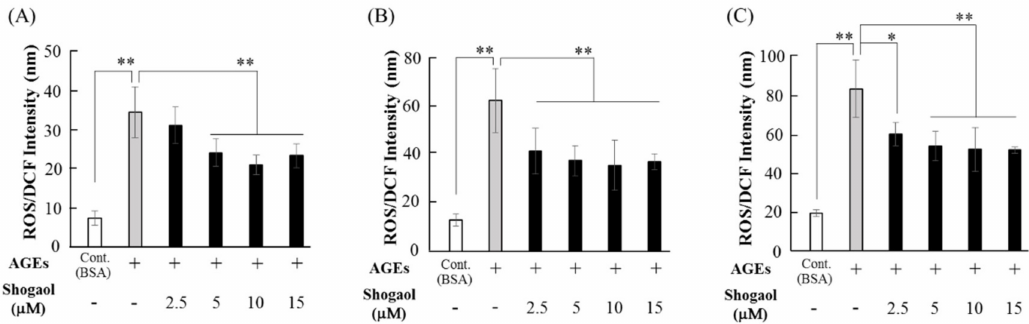
Figure 2. E ff ects of 6-shogaol on AGEs-induced ROS activity. Sub-confluent HGFs were pretreated with 6-shogaol (2.5–15 µ M) for 1 h and cultured with AGEs (500 µ g / mL) or BSA (500 µ g / mL) for 12 h ( A ), 24 h ( B ), or 48 h ( C ). ROS activity was assessed by measuring a fluorescence intensity of 2 (cid:48) ,7 (cid:48) -dichlorofluorescein (DCF) in HGFs treated with AGEs, BSA and 6-shogaol using an ROS activity ( A , B ) and 4 ( C ) independent experiments (* p < 0.05, ** p < 0.01).